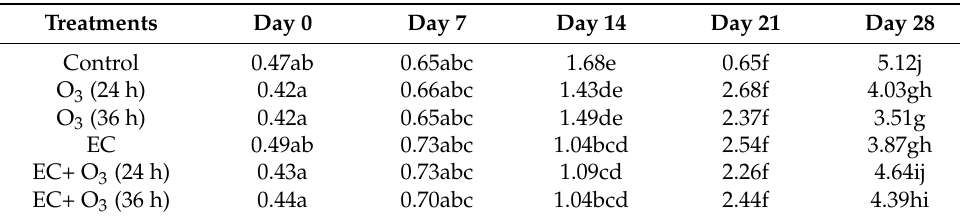
Table 2. Effect of edible coating (EC) and gaseous ozone (O 3 ) on mango peel lipid peroxidation (MDA ngmol − 1 g − 1 ) during storage for twenty-one days at 10 ◦ C and shelf-life for seven days at ambient temperature. Data represent means (LSD = 0.50, n = 9).